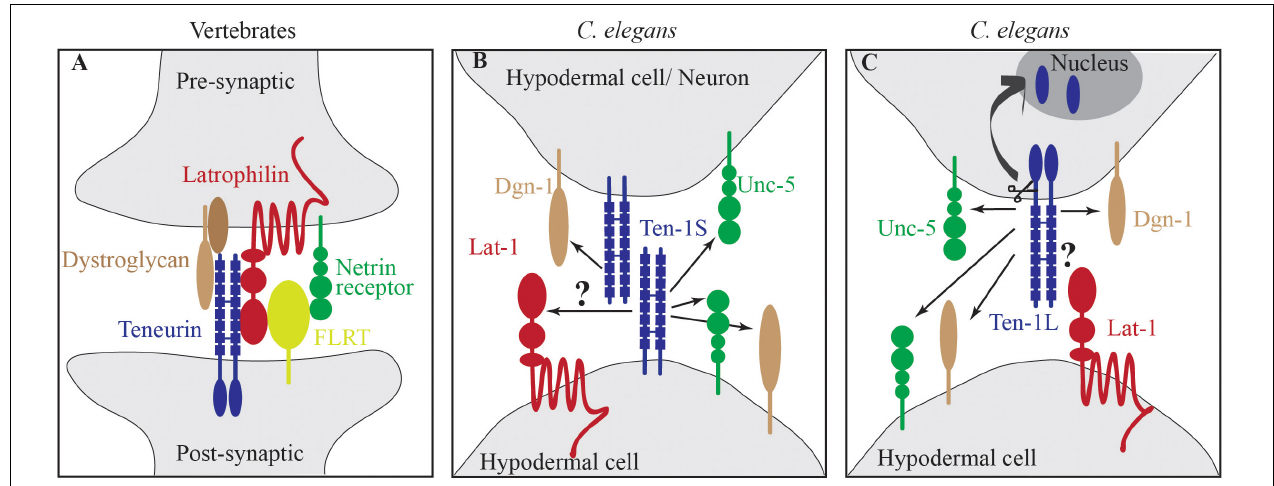
FIGURE 1 | Teneurin-latrophilin interactions. (A) In vertebrates, teneurin is a part of protein complexes that connect pre- and postsynaptic parts of neurons. Teneurin physically interacts with latrophilin and also with the basement membrane receptor dystroglycan. Latrophilin is connected to the netrin receptor via FLRT. (B) C. elegans TEN-1S is expressed in hypodermal cells and neurons and genetically interacts with dystroglycan Dgn-1 and the netrin receptor Unc-5. The latrophilin LAT-1 is expressed in hypodermal cells. Whether TEN-1S and LAT-1 interact is unknown (arrow with question mark). (C) C. elegans TEN-1L is expressed in many more cells and tissues compared with LAT-1. Thus, cis interactions might be possible but have not yet been proven. A presumed interaction between TEN-1L and LAT-1 could trigger the release of the intracellular domain of TEN-1L, initiating cell signaling pathways. FLRT, (fibronectin leucine-rich repeat transmembrane protein), arrows indicate genetic